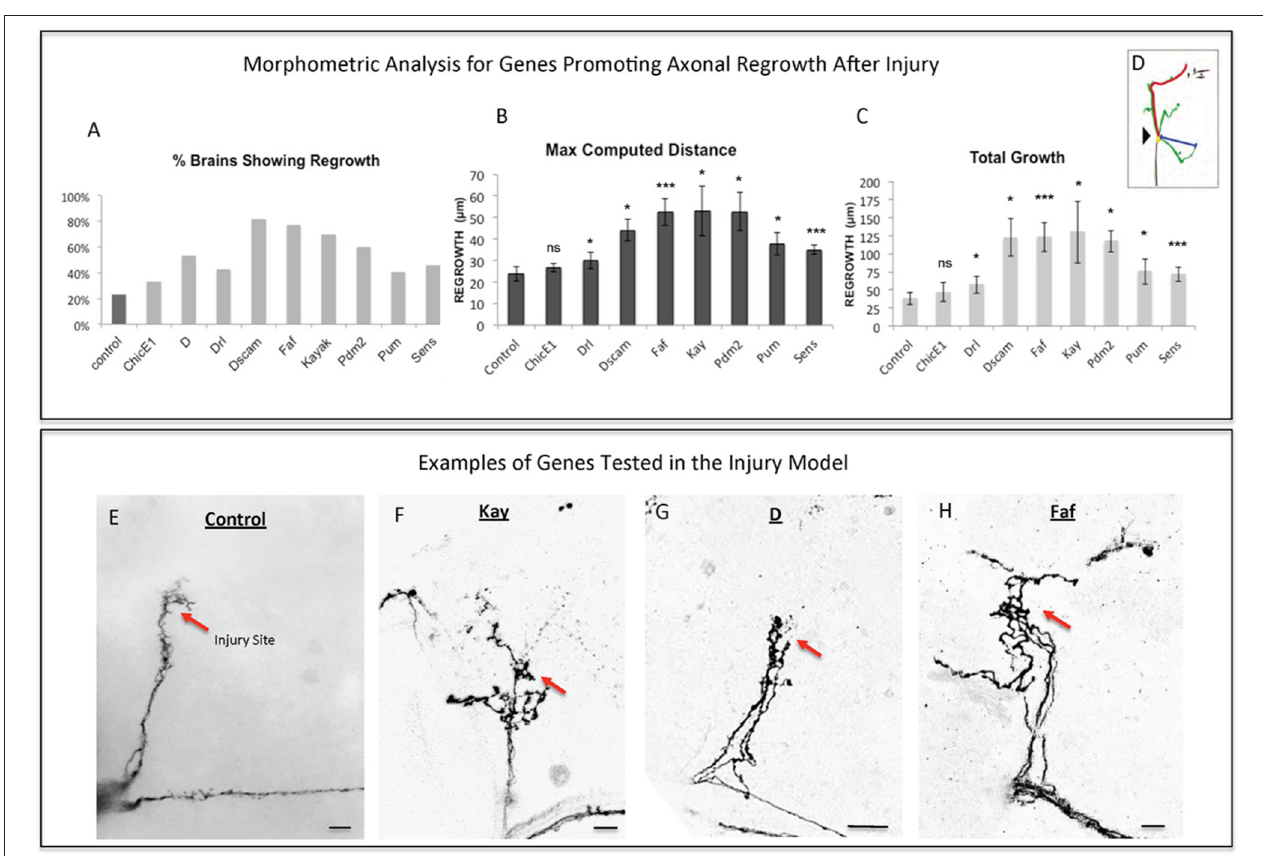
FIGURE 3 | Analysis of axonal regrowth in the regeneration screen. (A–D) Analysis of axonal regrowth 4 days after injury. (A) Percentage of brains where at least one regenerated axonal sprout is detected (Capacity of regrowth). (B,C) Morphometric analysis [Maximum Computed Distance, (B) and Total Growth (C) ] of regenerated sLNv axonal sprouts. Axonal regrowth is measured in µ m. (D) Schematic simplifying how length of the regrown axonal sprouts is assessed. Yellow dot shows the point of injury; red trace represents maximum axonal length; blue trace represents axonal length measured in a straight line. (E–H) Representative images of sLNv axonal regrowth 4 days after injury in wild type (control) adult flies (E) and in flies where overexpression of Kayak , kay (F) , Dichaete , D (G), and Fat Facets , faf (I) has been specifically induced in the sLNvs. Genotype of flies in (E) is PDF-Gal4, UAS-GFP/ + ; PDF-Gal4, UAS-2x eGFP/ + , in (F) is PDF-Gal4, UAS-GFP/ + ; PDF-Gal4, UAS-2x eGFP/ + ; UAS-Kay/ + , in (G) is PDF-Gal4, UAS-GFP/ + ; PDF-Gal4, UAS-2x eGFP/ + ; UAS-D/ + , in (H) is PDF-Gal4, UAS-GFP/ + ; PDF-Gal4, UAS-2x eGFP/ + ; UAS-Faf/ + . Red arrow denotes the injury point. * p < 0.05; *** p < 0.001. n.s. indicates no statistical significance. Error bars represent SEM. Scale bars are 20 µ